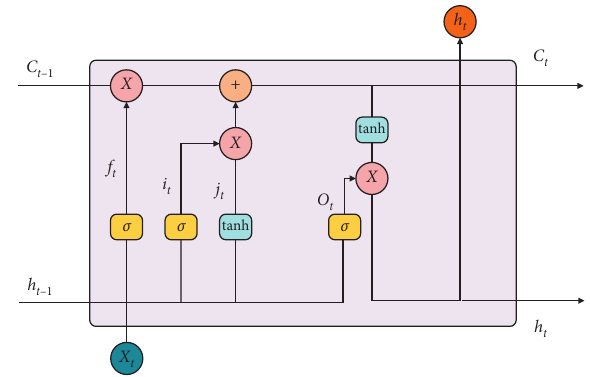
Figure 5: LSTM hidden layer structure diagram.